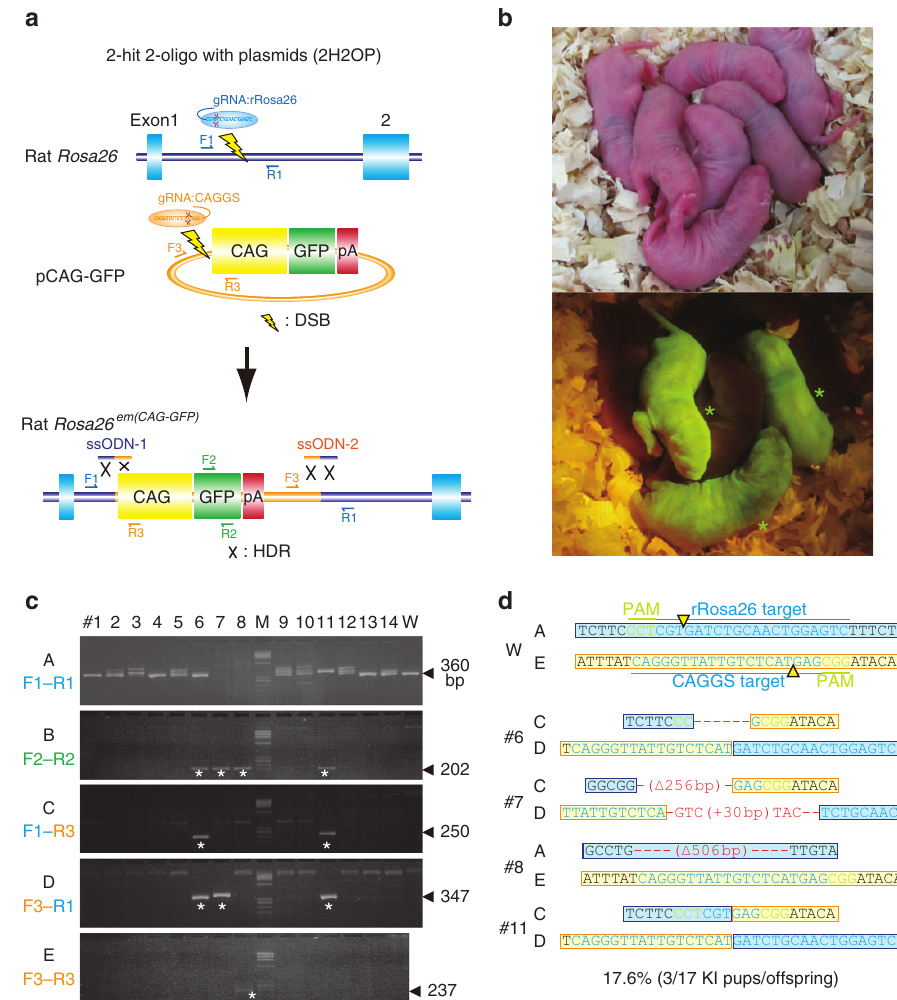
Figure 3 | CAG-GFP KI rats generated using the CRISPR-Cas system. ( a ) Schematic representation of the two-hit two-oligo with plasmid (2H2OP) method. In the first step, Cas9, together with two gRNAs targeting the rat Rosa26 locus and the CAG promoter in the GFP plasmids, cut the target sites. In the second step, two ssODNs ligate each cut end to join the genomic DNA and the plasmid DNA via HDR. ( b ) Photos of pups delivered from Wistar rat embryos injected with a mix of Cas9-poly(A) mRNA, two gRNAs, two ssODNs and CAG-GFP plasmids (upper). Some of the pups (numbers 6, 7 and 8) expressed GFP at a high level in the body (asterisk) (lower). ( c ) PCR analysis of the pups with primer sets F1–3 and R1–3, as indicated in a . Many pups showed indel mutations at the targeted Rosa26 locus, compared with the 360-bp wild-type allele indicated by arrows (Supplementary Fig. 9) (A). Four pups showed a GFP-positive PCR band (asterisk) (B). Three pups, numbers 6, 7 and 11, were positive for the ligation between either side of Rosa26 and CAG-GFP (C,D). Rat number 8 was positive for the uncut CAG sequences (E). Arrows indicate the predicted PCR size. ( d ) Sequence analysis of pups indicated that rat number 11 carried accurate conjunction at both cut